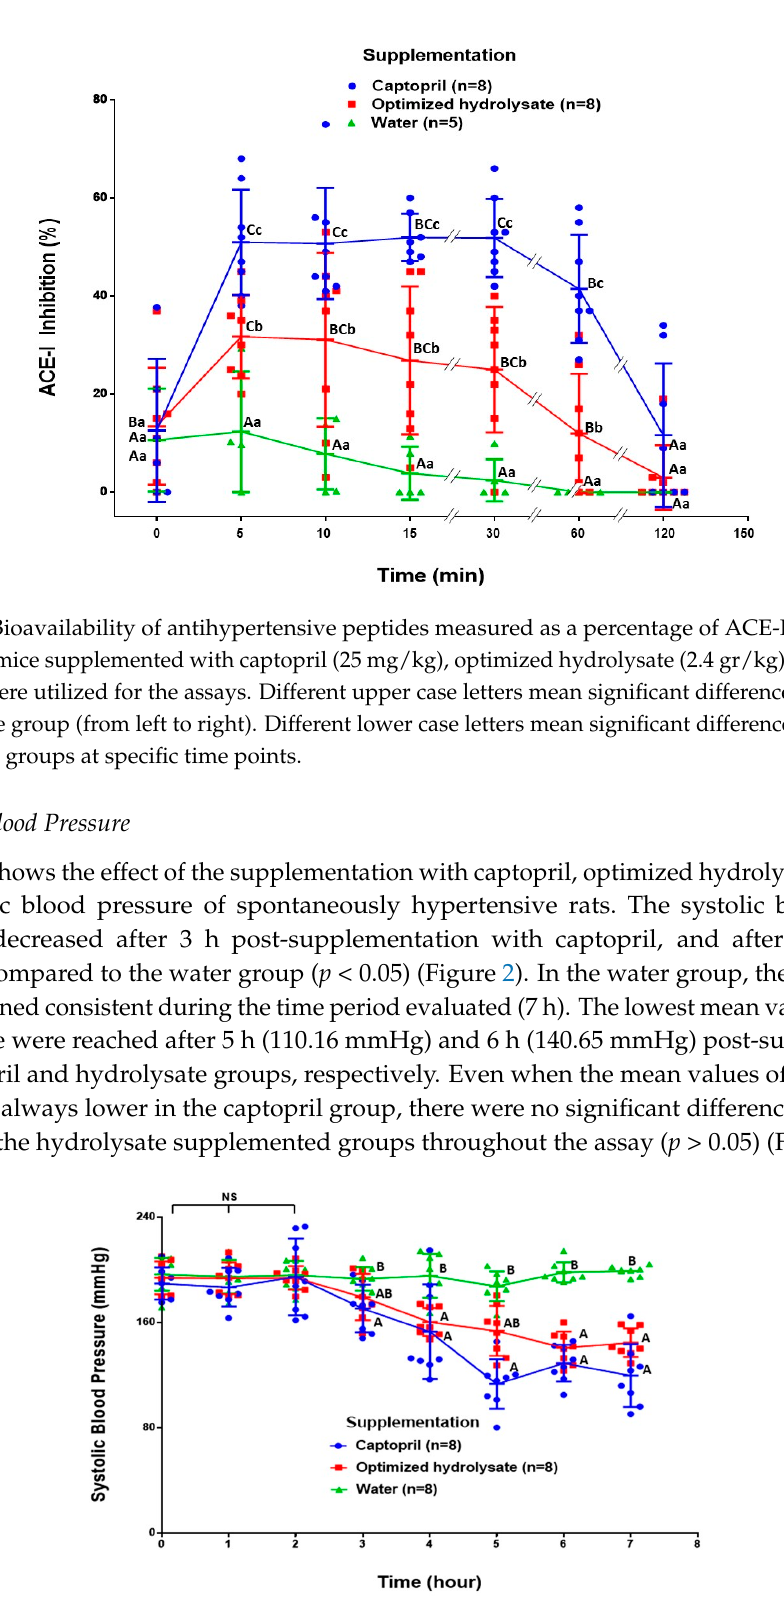
Figure 2. Systolic blood pressure in spontaneously hypertensive rats after supplementation with captopril (25 mg/kg body weight), optimized hydrolysate (1.2 g/kg body weight), and water (1.5 mL). Different letters mean statistical difference ( p < 0.05). NS; non-significant difference.